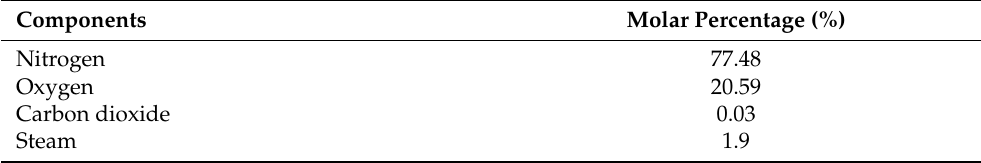
Table 1. Molar percentages of the inlet air components into the combustion chamber.